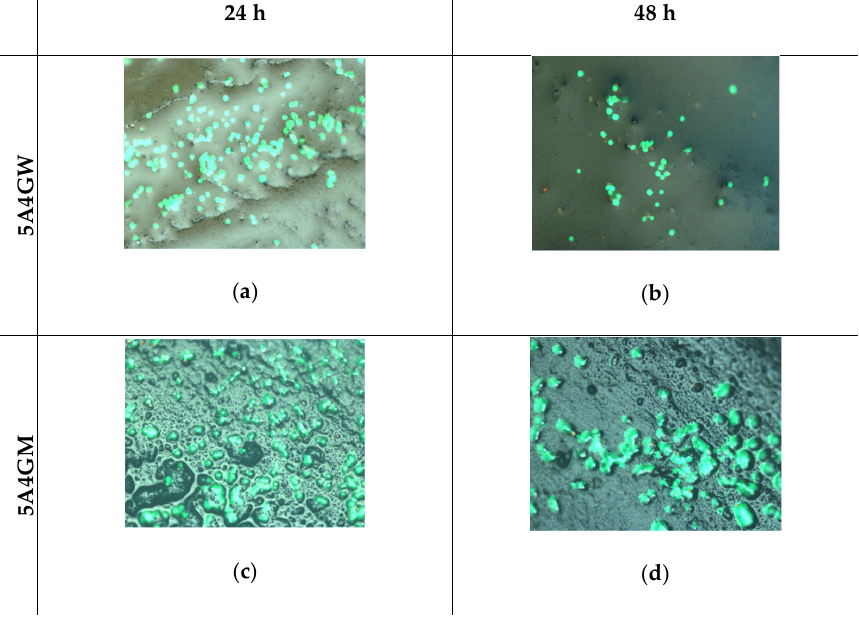
Figure 8. Endothelial cells (EA.hy 926 line) cytotoxicity after direct contact with 5A4GW and 5A4GM samples after 24 ( a , c ) and 48 h ( b , d ) of incubation (live cells are marked green, dead in red). Magnification